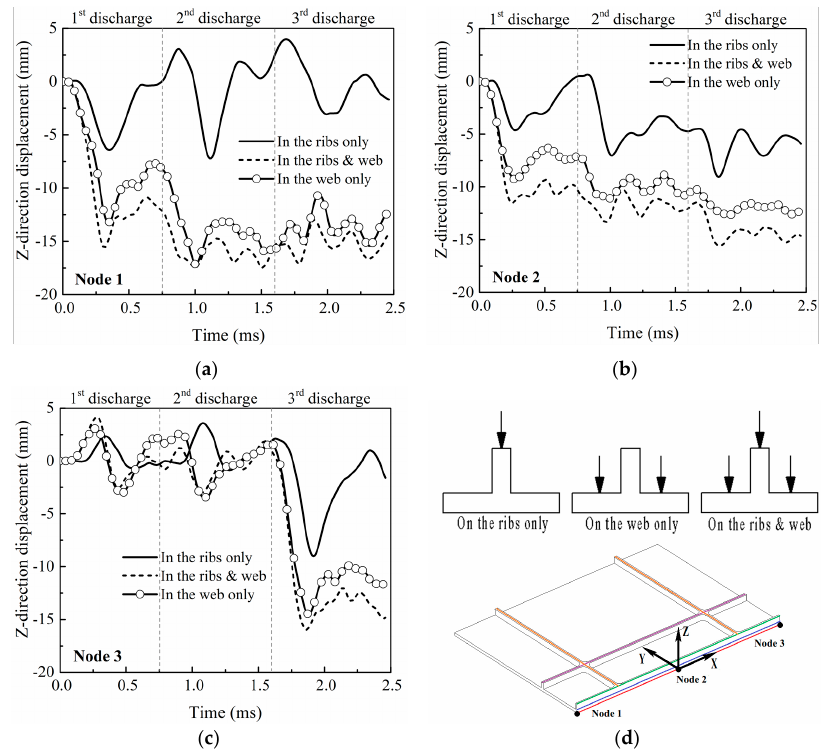
Figure 7. Z -direction displacement with forces loading in different positions at ( a ) Node1; ( b ) Node 2; ( c ) Node 3; ( d ) sketch. ( c ) Node 3; ( d )